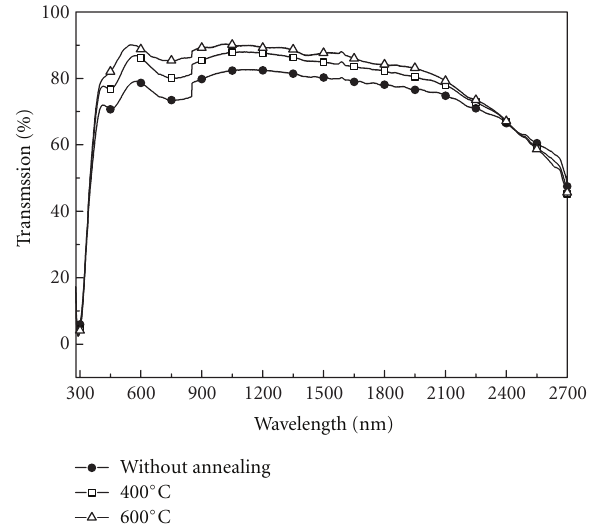
Figure 7: Optical transmittance spectra of the ITO thin films treated without annealing and with annealing at 400 ◦ C and 600 ◦ C in 3% H 2 /97% N 2 mixtures